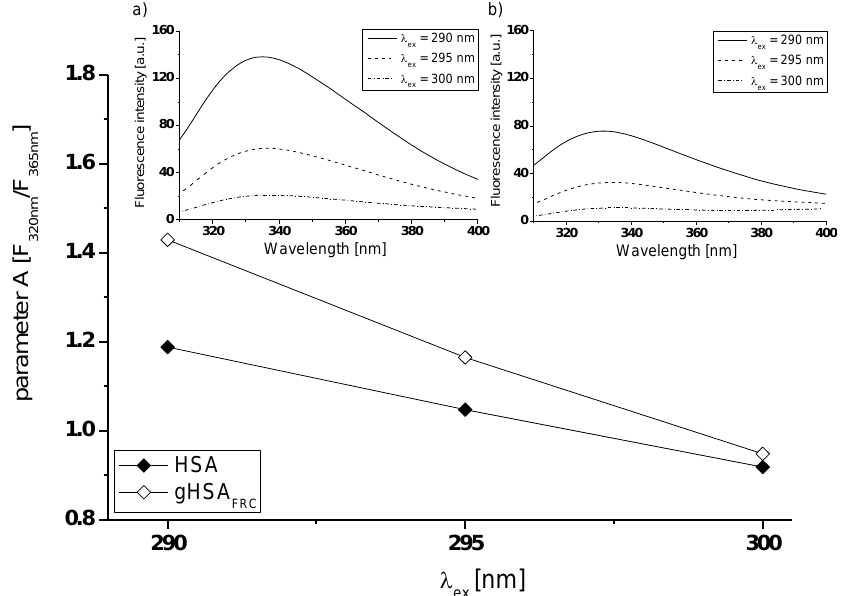
Figure 5. Main view: a plot of parameter A = F 320 nm F 365 nm vs. the excitation wavelength ( λ ex ) for HSA and gHSA FRC at 5 × 10 − 6 mol · L − 1 concentration. Insert: emission fluorescence spectra of ( a ) HSA and ( b ) gHSA FRC albumin excited at λ ex = 290 nm, λ ex = 295 nm and λ ex = 300 nm. Error bars (error determined as a maximum deviation) are smaller than the symbols.